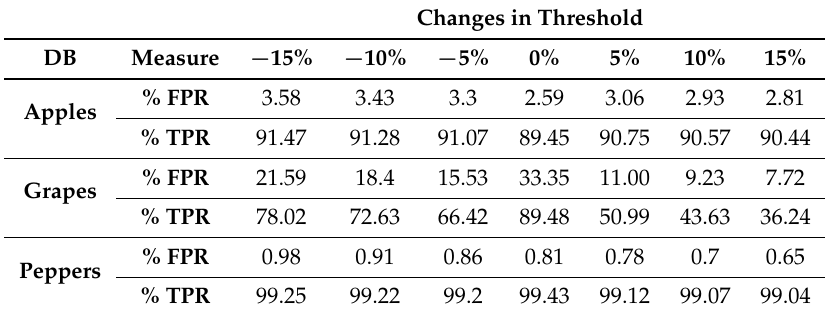
Table 6. Threshold values changed by ± 5%, ± 10%, and ± 15% according to the threshold in each region.